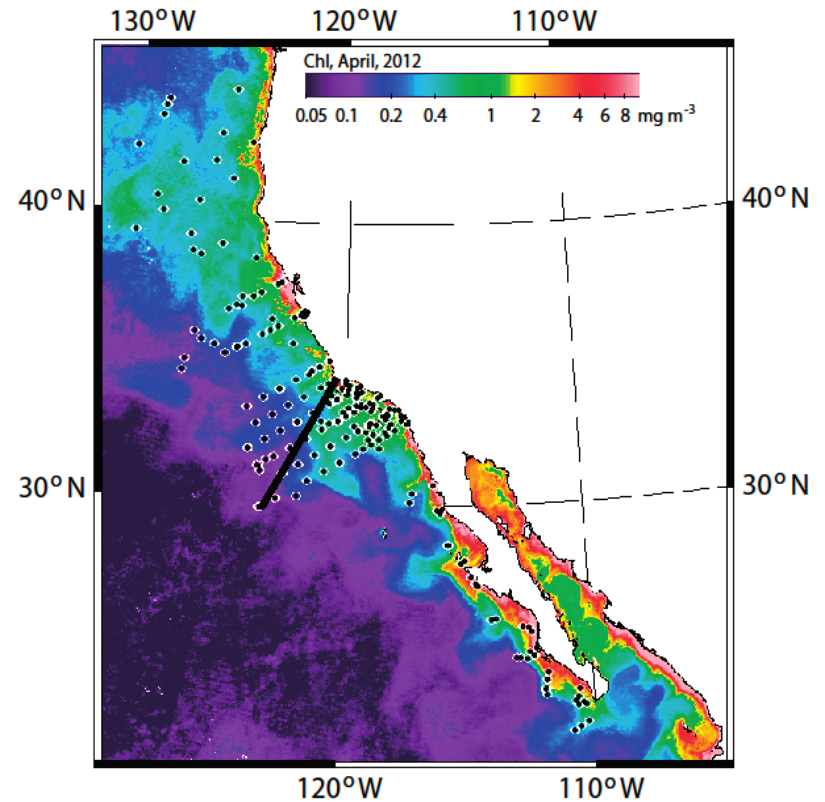
Figure 1. Locations of the MODIS-Aqua Chla match-ups (black dots with white circles) within 3 h time difference overlaid on the April 2012, Chla composite. The black line shows the location of the 5 km-wide strip from the coast to offshore along which satellite-to-satellite match-ups were